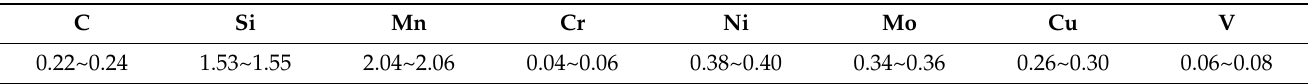
Figure 1. ( a ) The thermal treatment process of the test steel, and ( b ) calculated CCT diagram of the test steel using JMat-Pro. Table 1. Chemical composition (wt%) of the test